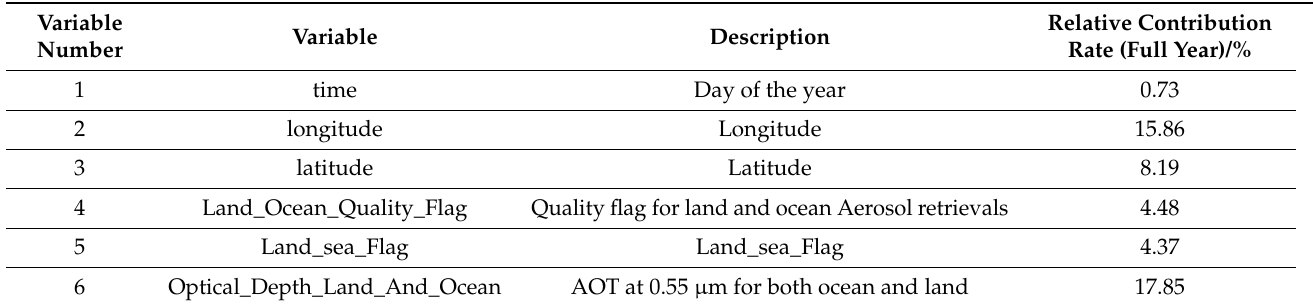
Table A1. Remote sensing variable information and MIV evaluation result